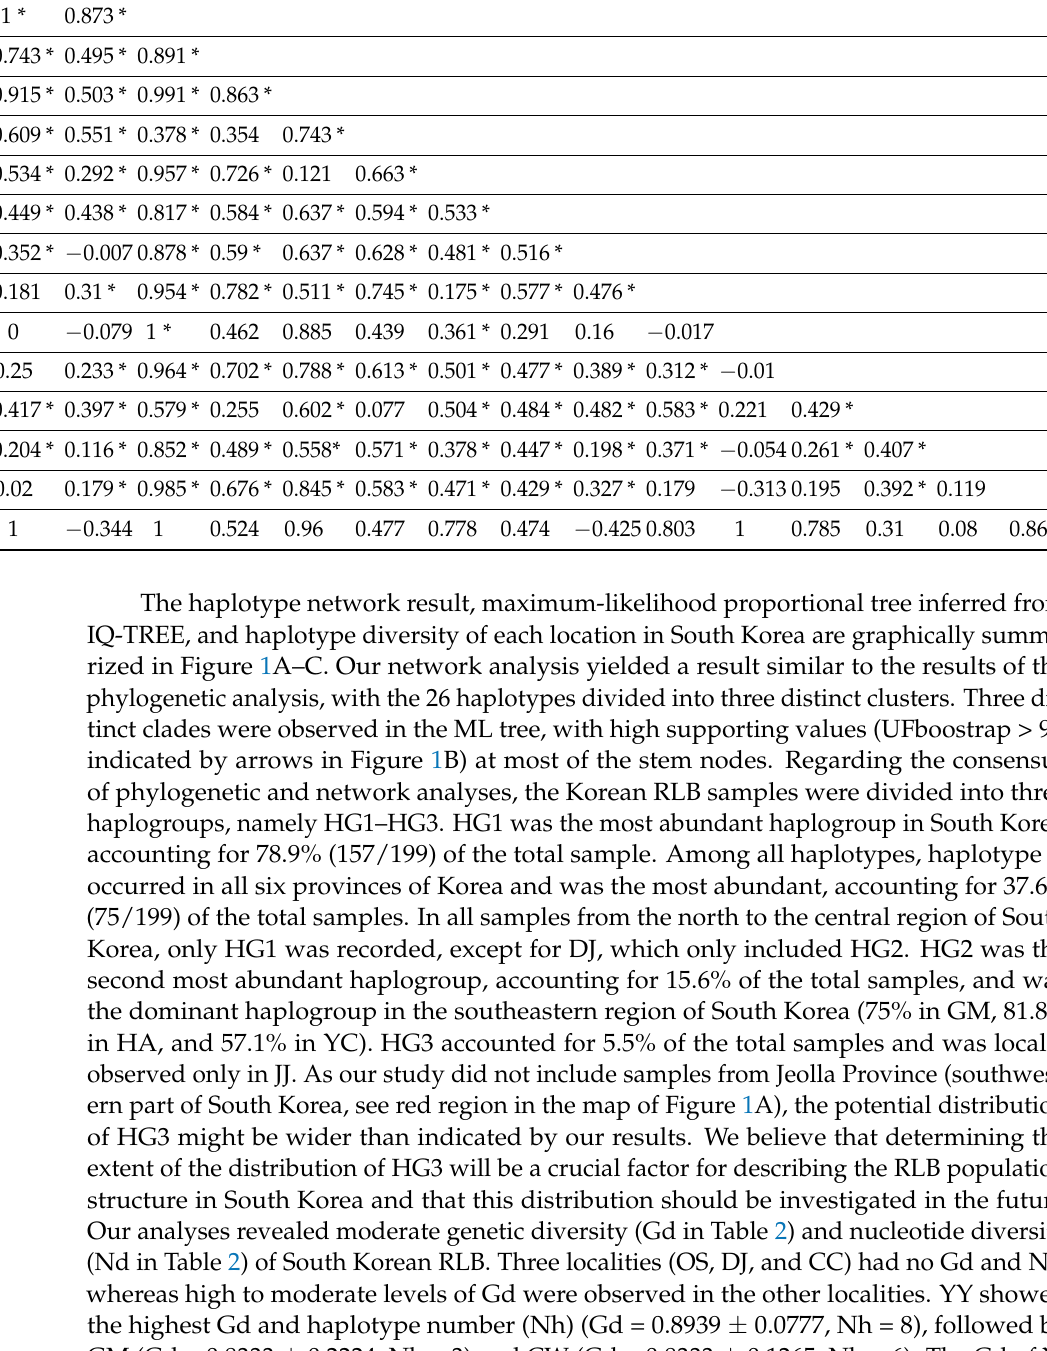
Table 3. Pairwise FST calculated by Arlequin based on 1248 bp of COI sequence dataset (* = p -value < 0.05). AD BY CC CW DJ GM GY HA IC JJ MK SU OS PT YC YY YW AD